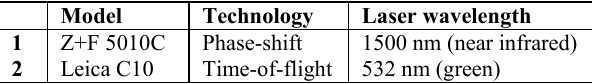
Table 1 . Main features of the two laser scanners.